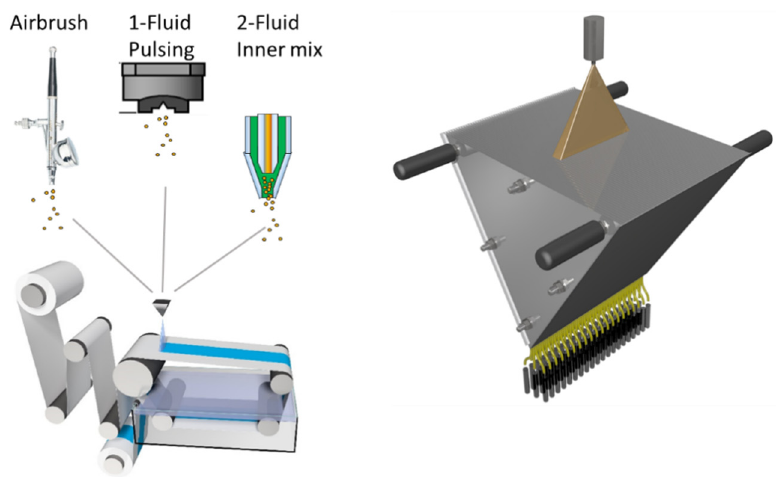
Figure 1. Schematic presentation of the membrane production process with three different spraying techniques combined with a membrane casting machine including a non-solvent bath ( left ) and spray collector ( right ).